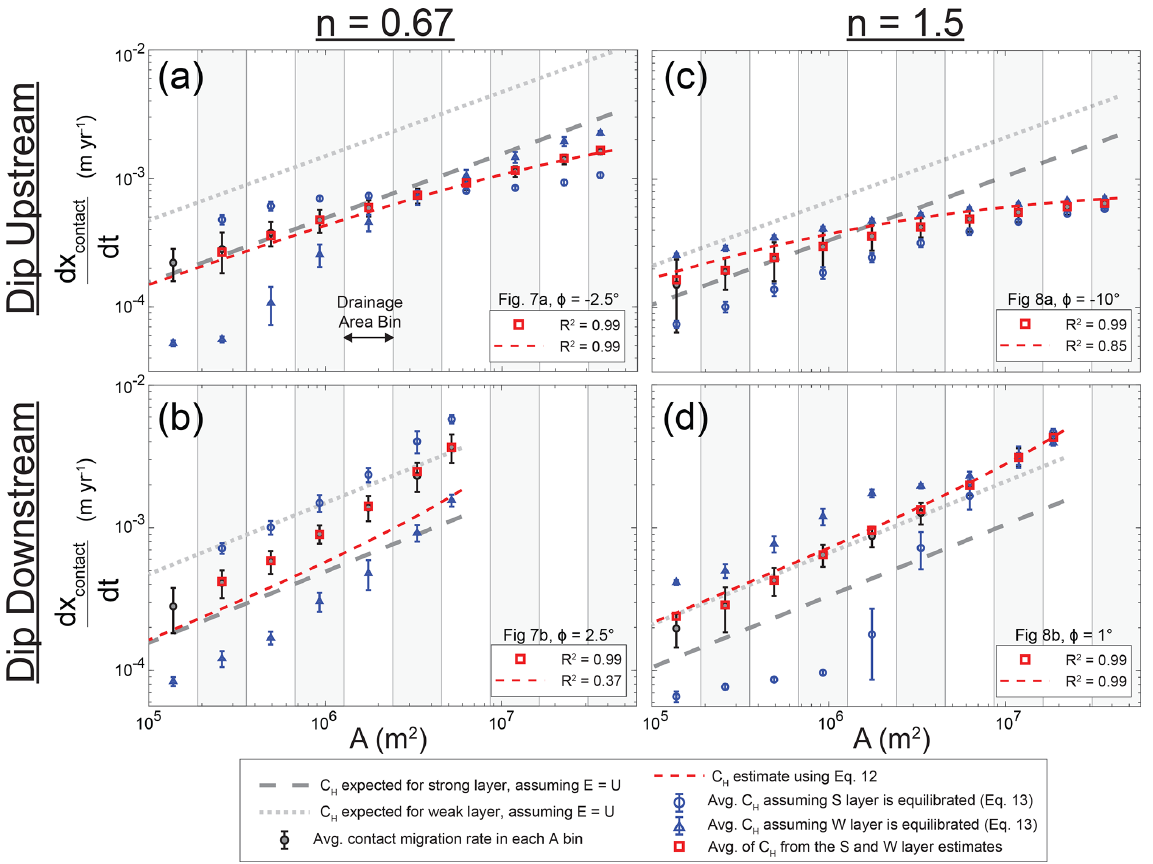
Figure 9. Contact migration rates (d x contact / d t ) vs. drainage area ( A ) for the four simulations shown in Figs. 7 and 8. The simulations have slope exponent ( n ), weak erodibility ( K W ), and strong erodibility values ( K S ) of (a, b) n = 0 . 67, K W = 6 . 83 × 10 − 6 m 0 . 33 yr − 1 , and K S = 3 . 25 × 10 − 6 m 0 . 33 yr − 1 and (c, d) n = 1 . 5, K W = 4 . 44 × 10 − 8 m − 0 . 5 yr − 1 , and K S = 1 . 57 × 10 − 8 m − 0 . 5 yr − 1